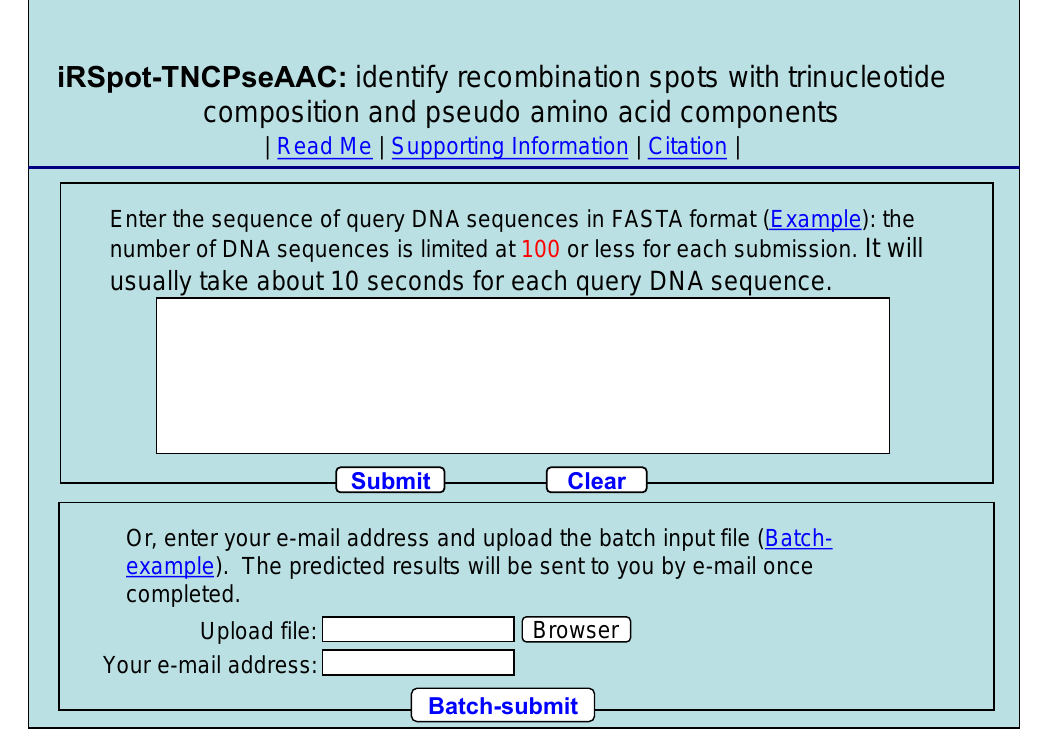
Figure 3. A semi-screenshot for the top page of the web-server iRSpot-TNCPseAAC at